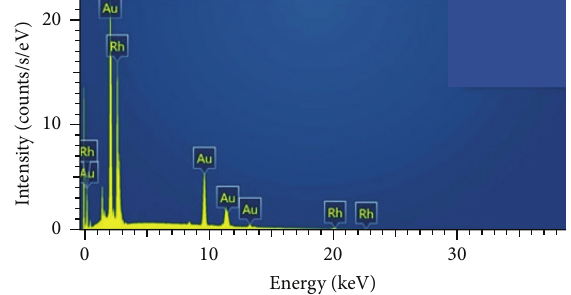
Figure 4: EDXA spectrum of the contacting surface of WS switch. The elemental composition (wt.%) is Au 54.7 and Rh 45.3. Figure 5: Enlarged SEM image (